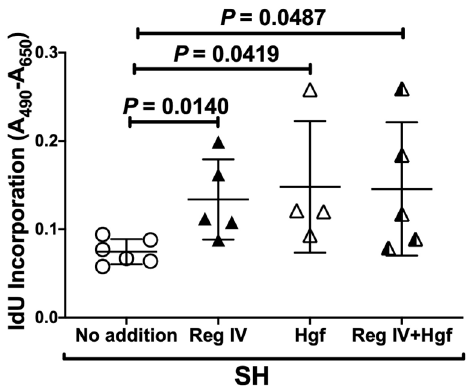
Figure 6. Replicative DNA synthesis of mouse P19.CL6 cardiomyocytes incubated in SH in the presence/absence of Reg IV (0.1 ng/mL) and/or Hgf (0.1 ng/mL). P19.CL6 cells were exposed to SH (1% O 2 ) for 24 h, and replicated DNA synthesis was measured by IdU incorporation. Data were ex-